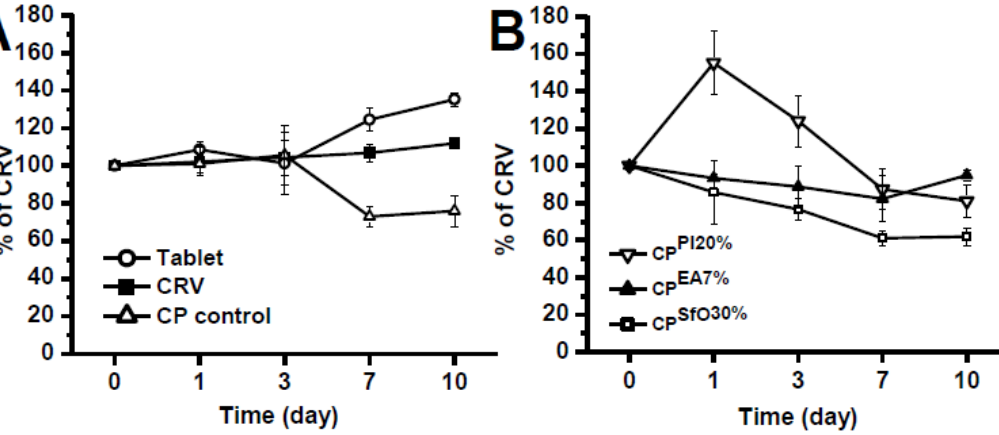
Figure 6. Results shown for CRV decay in different CPs binary systems at a 50 °C ( A ) and under darkness for up to 10 days of storage ( B ).